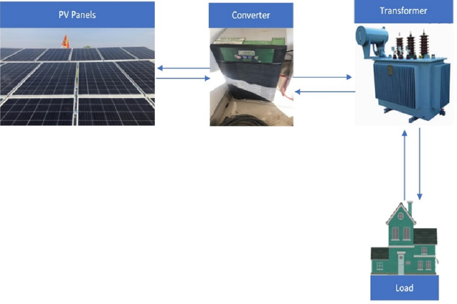
Figure 1. Transition diagram of proposed microgrid model.